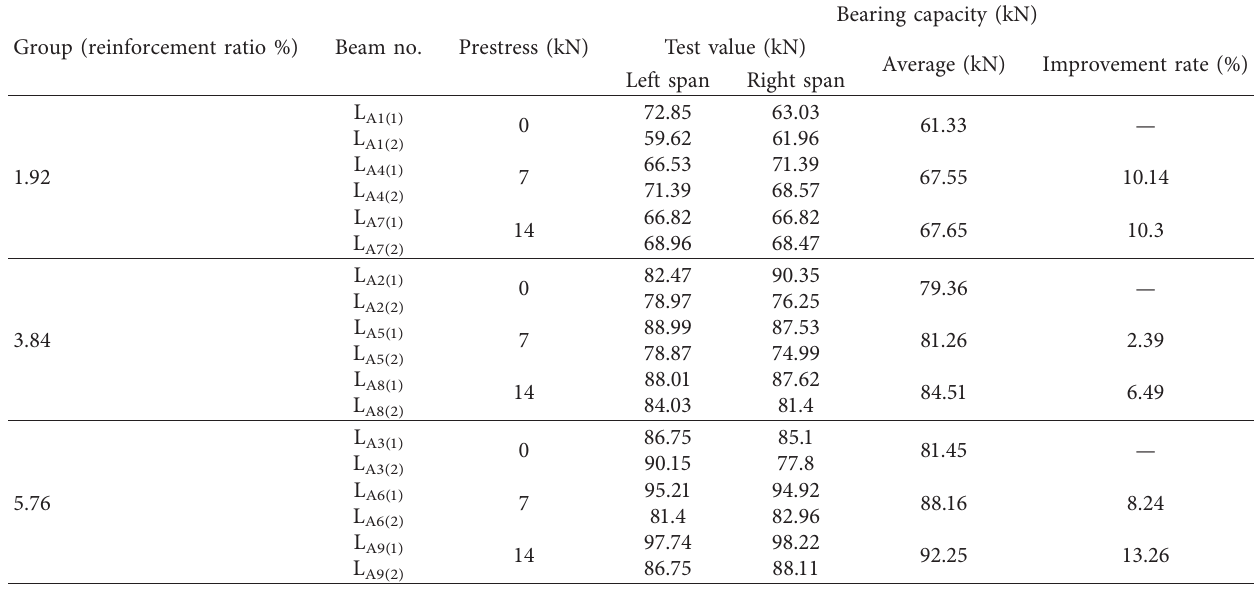
Table 6: Bearing capacity of beams with different numbers of steel bars. Group (reinforcement ratio %) Beam no.